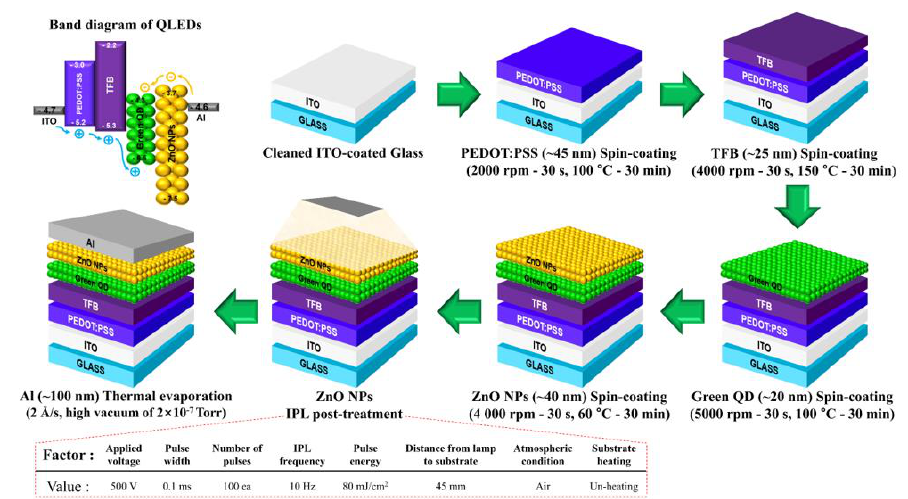
Figure 1. Band diagram structure and fabrication schematics for quantum-dot light-emitting diodes (QLEDs). All of the annealing process was conducted at N 2 atmosphere.